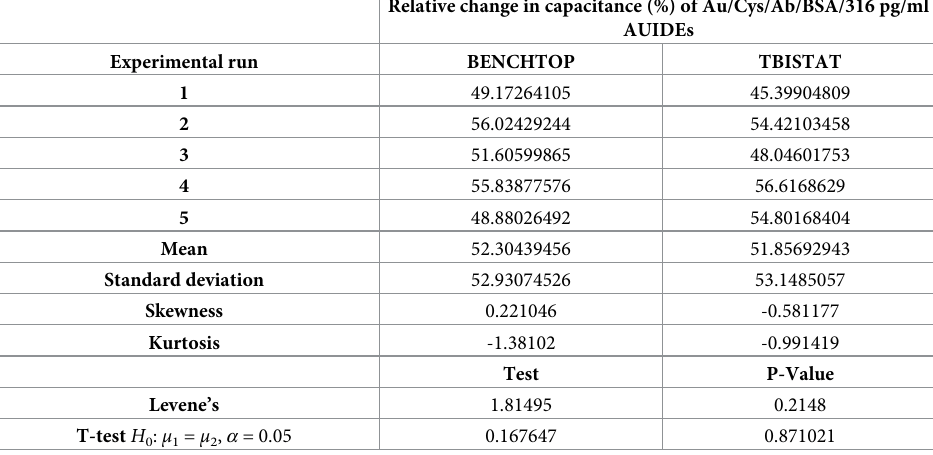
Table 3. Statistical analysis of single-frequency analysis